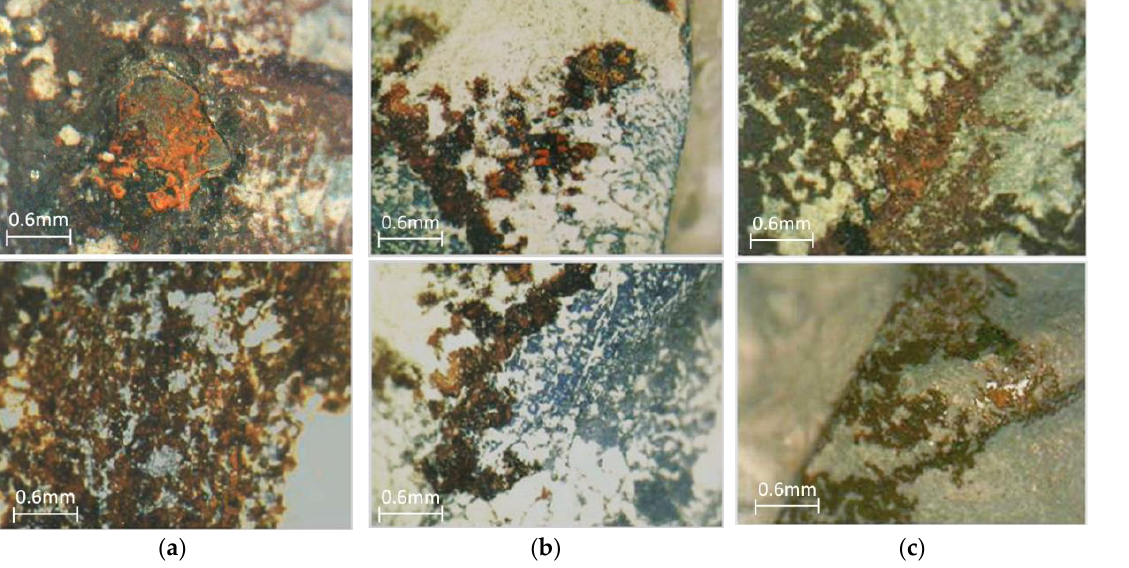
Figure 7. Optical microscopy (×50): ( a ) RM, ( b ) HDPE, ( c ) PP. From an optical microscopy and stereoscopy study of specimens, it seemed that the addition of thermoplastics did not seem to affect the extent of corrosion.